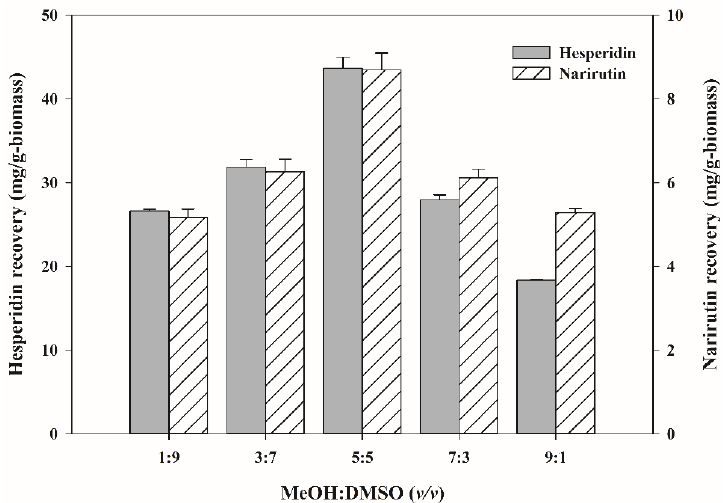
Figure 1. Effects of the mixing ratio of MeOH:DMSO solution on flavanone (hesperidin and narirutin) recovery from MPs.